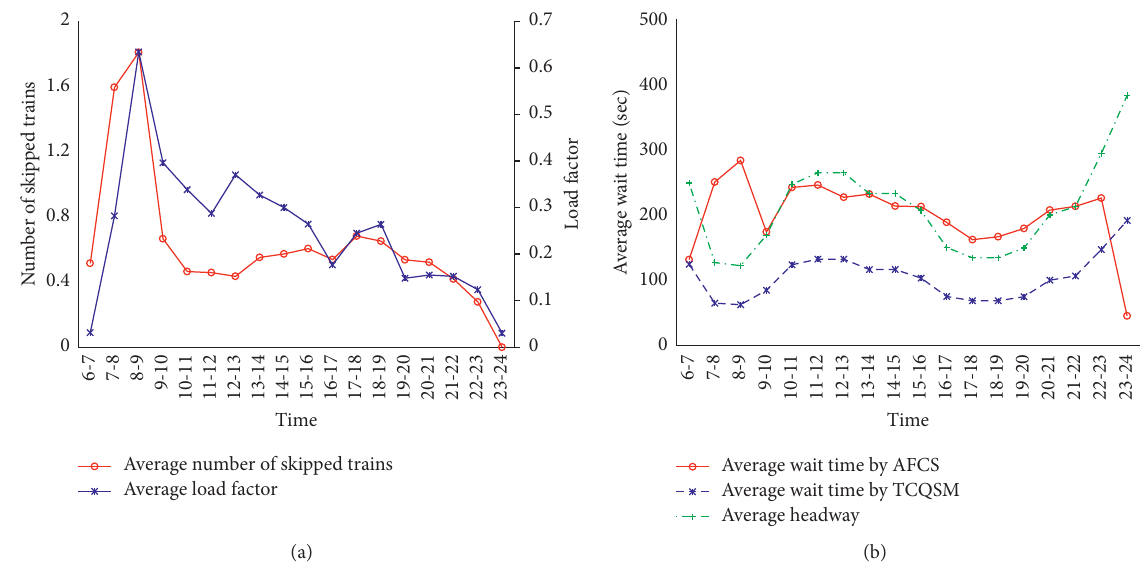
Figure 10: Number of skipped trains and average wait time at TFS station on line 1. (a) Number of skipped trains. (b) Average wait time.